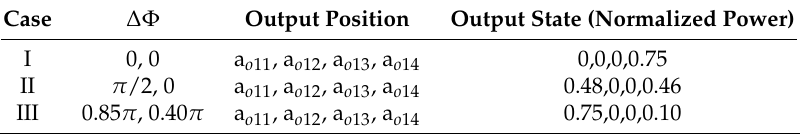
Table 3. Switching state of the device. The signal is fed at the input port a i 1